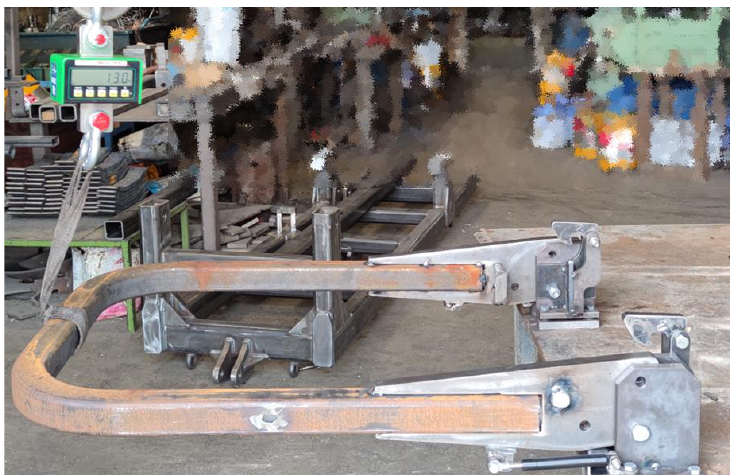
Figure 13. Preliminary setting operations.